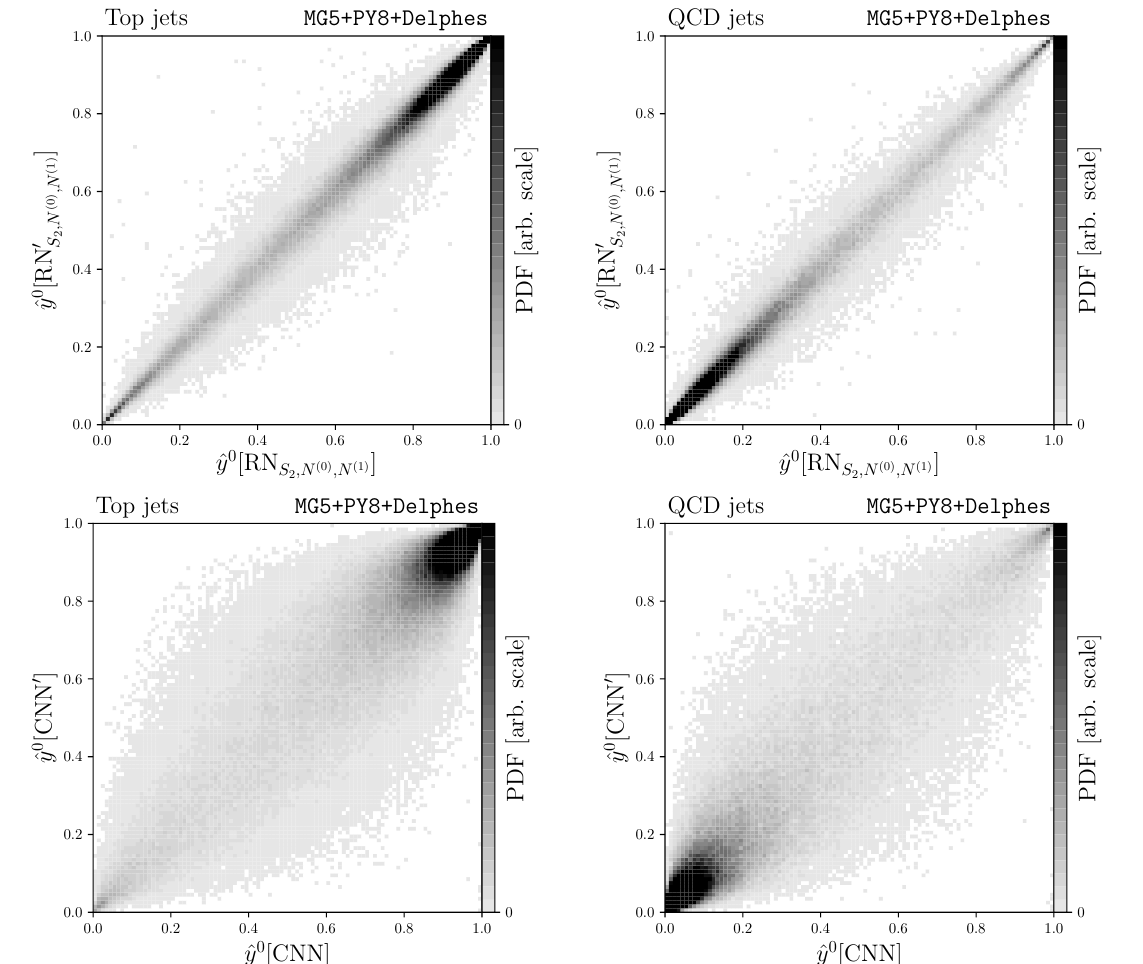
Figure 11. The distribution of softmax output of the classi(cid:12)ers for di(cid:11)erent random seed. upper two (cid:12)gures for ^ y 0 [RN ], and the bottom two (cid:12)gures for ^ y 0 [RN S 2 ;N (0) ;N (1) are top jets and the right (cid:12)gures are QCD